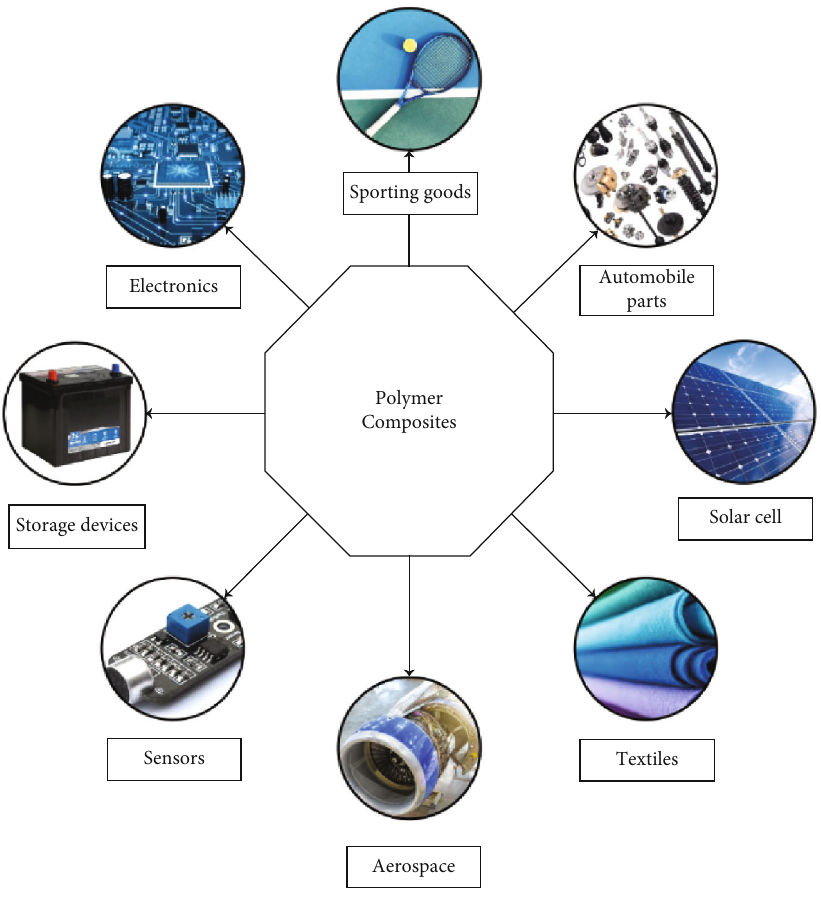
Figure 1: Application of polymer